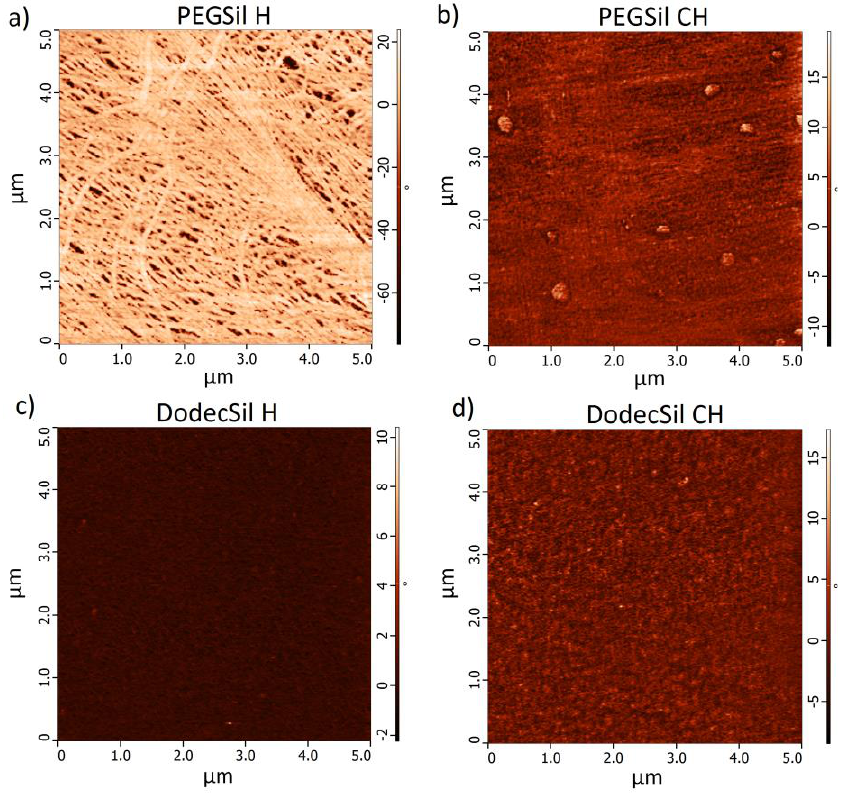
Figure A3. Atomic force microscopy (AFM) phase images from 5 × 5 μm areas between the electrodes of ( a )PEGSil H; ( b ) PEGSil CH; ( c ) DodecSil H; ( d ) DodecSilCH.